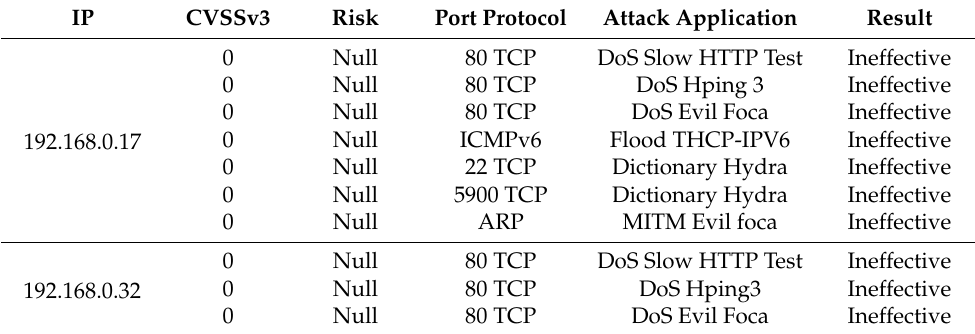
Table 25. Attacks founded